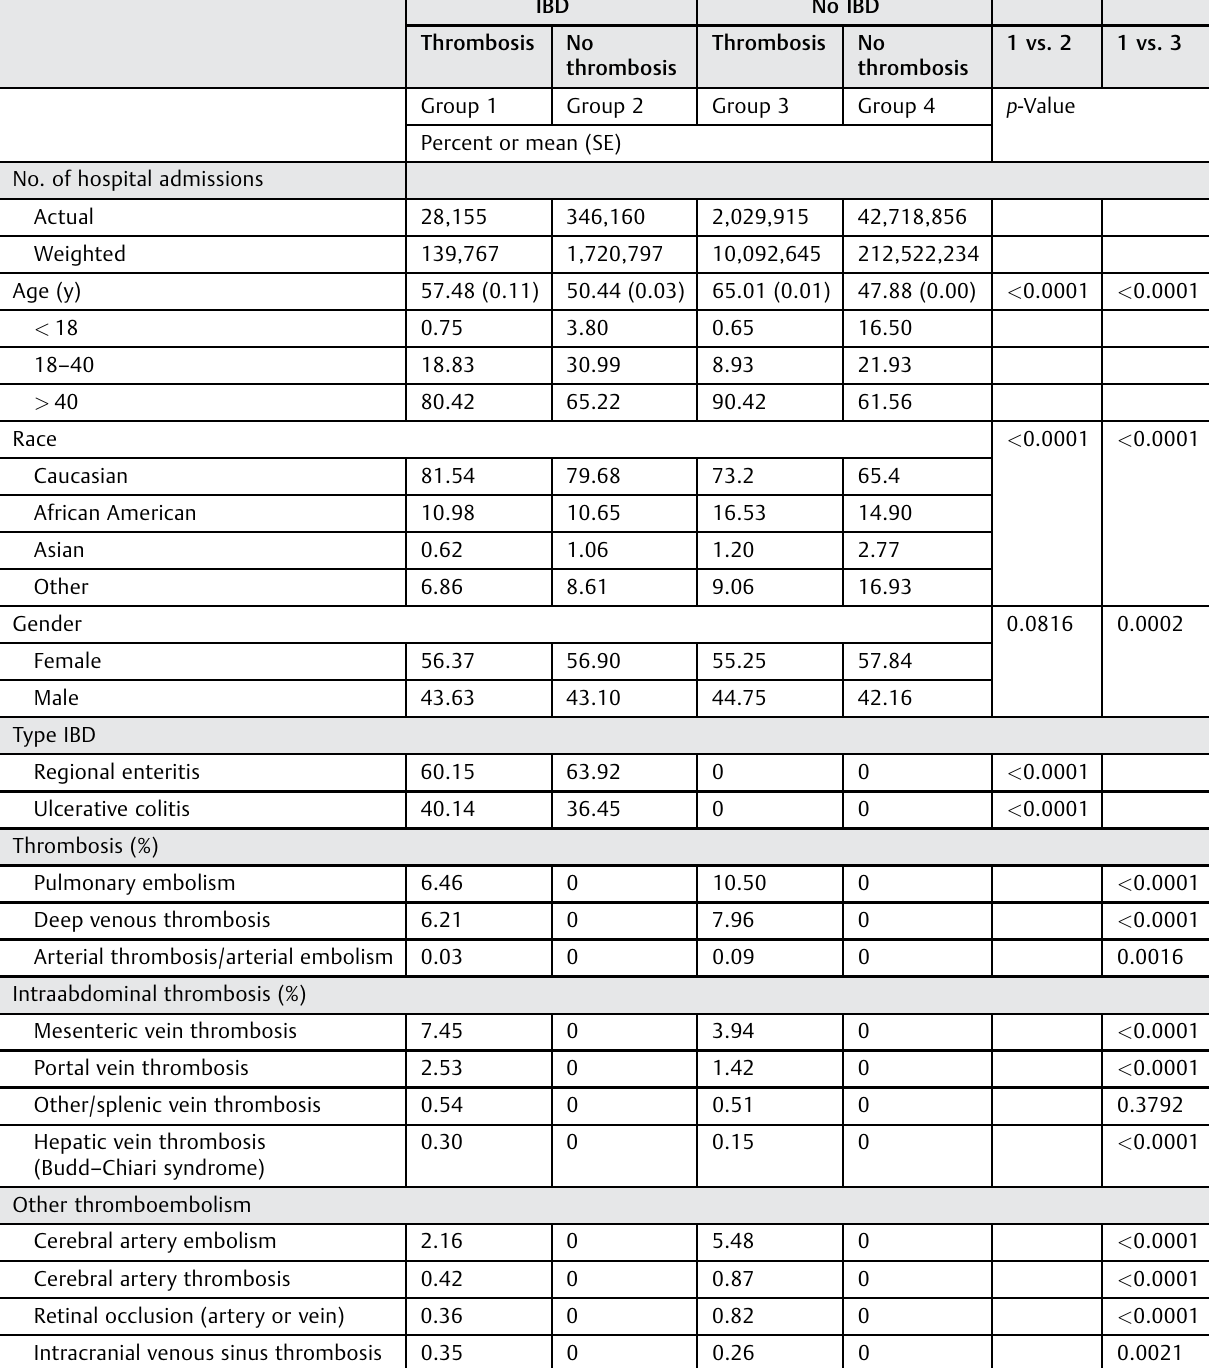
Table 2 Patient characteristics and risk factors for thrombosis by IBD and thrombosis status IBD No IBD Thrombosis No